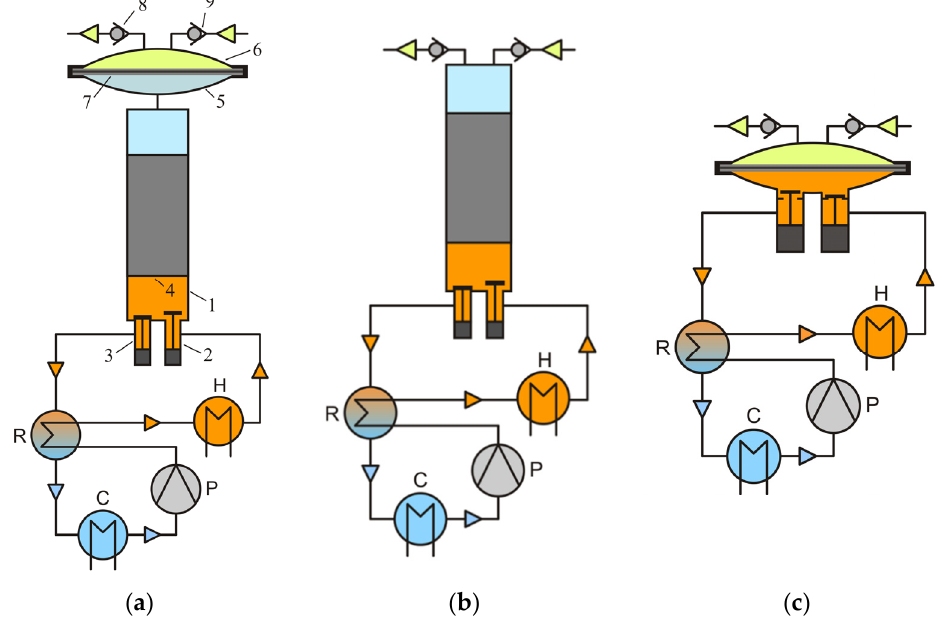
Figure 2. Regenerative Worthington-type engine with thermal barrier piston and diaphragm ( a ), with thermal barrier piston ( b ), with diaphragm ( c ). Pump (P), heater (H), recuperator (R), cooler (C). Cylinder (1) admission valve (2) exhaust valve (3), free piston (4), lower diaphragm cover (5), upper diaphragm cover (6), diaphragm (7), suction valve (8) and discharge valve (9).